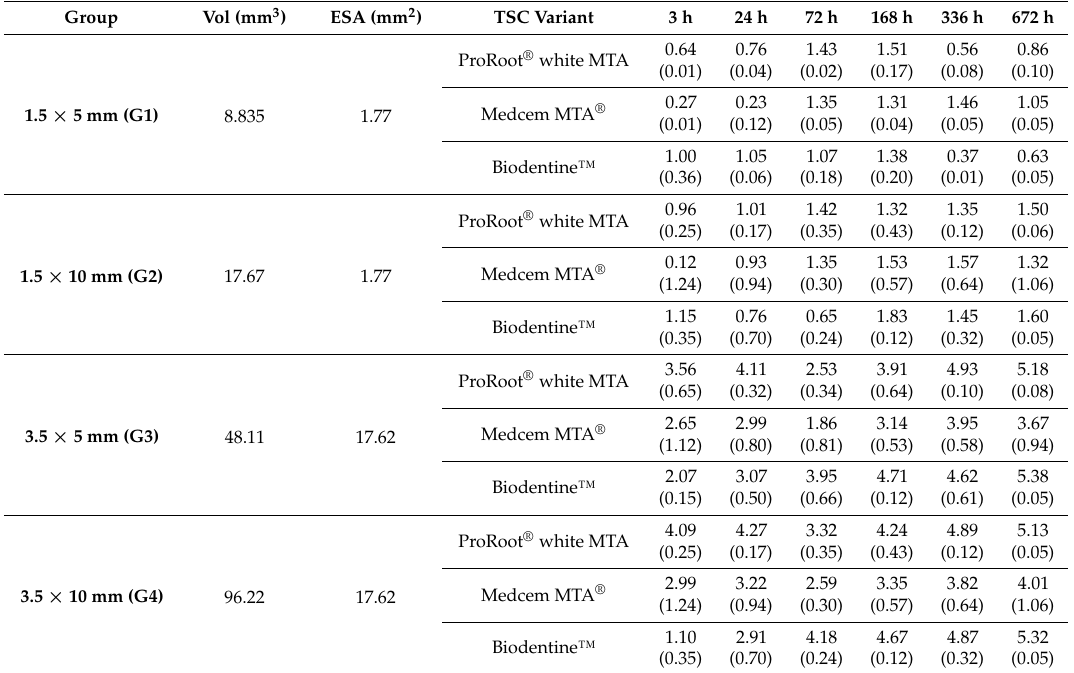
plotted versus the corresponding time in